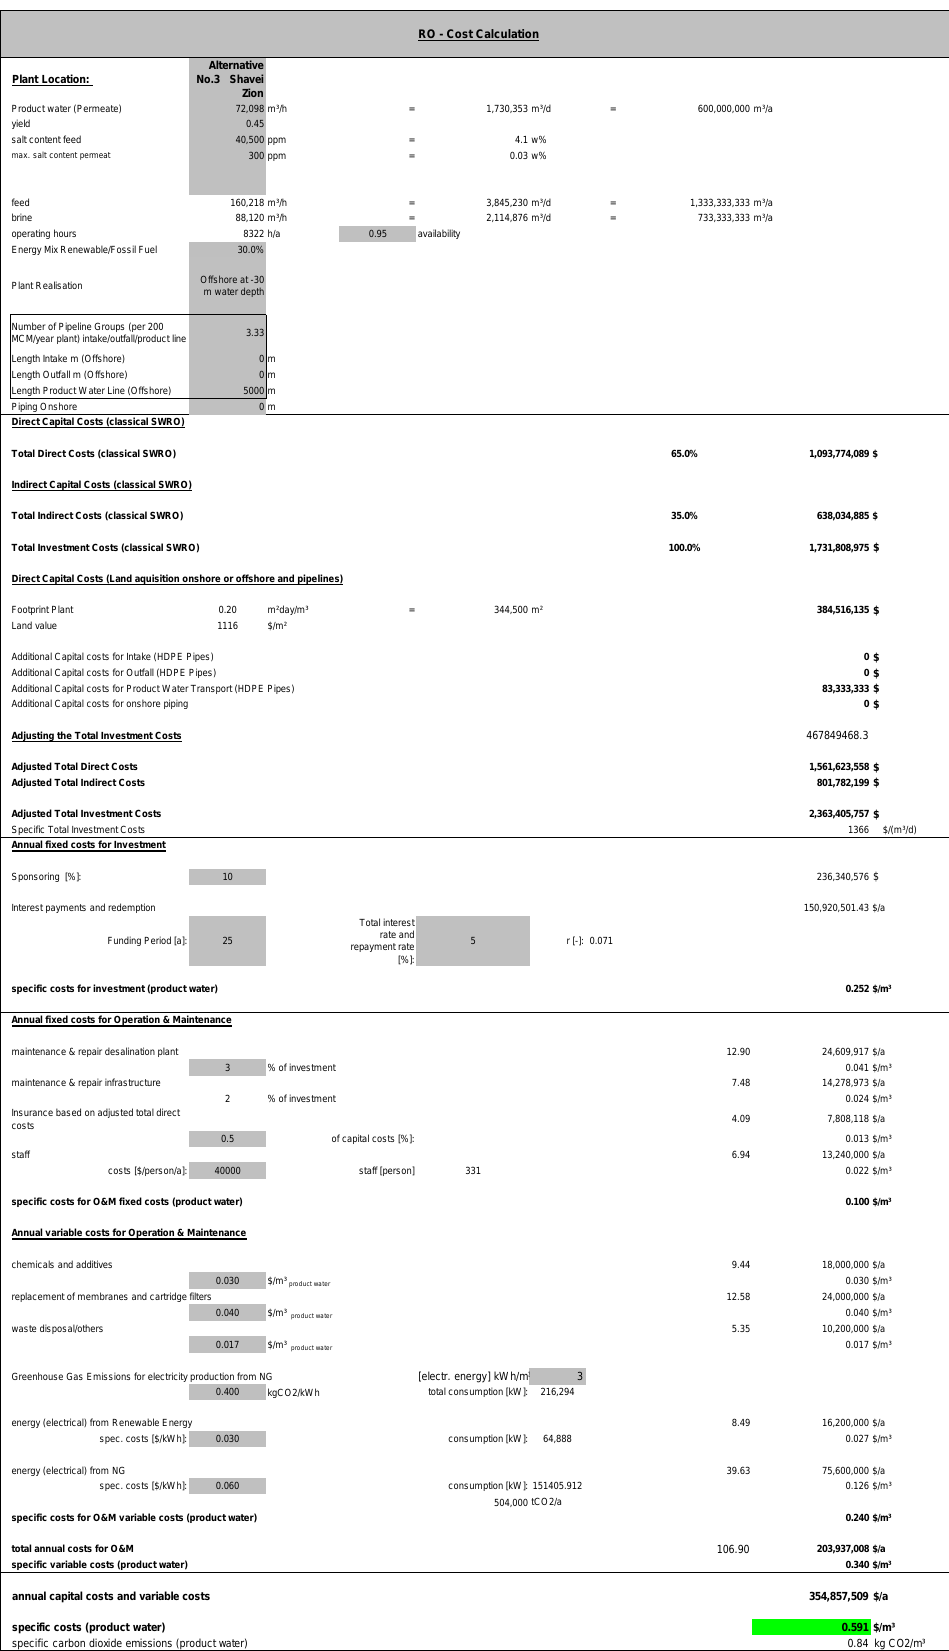
Figure A4. Detailed cost table for the economic analysis — Alternative No. 3.